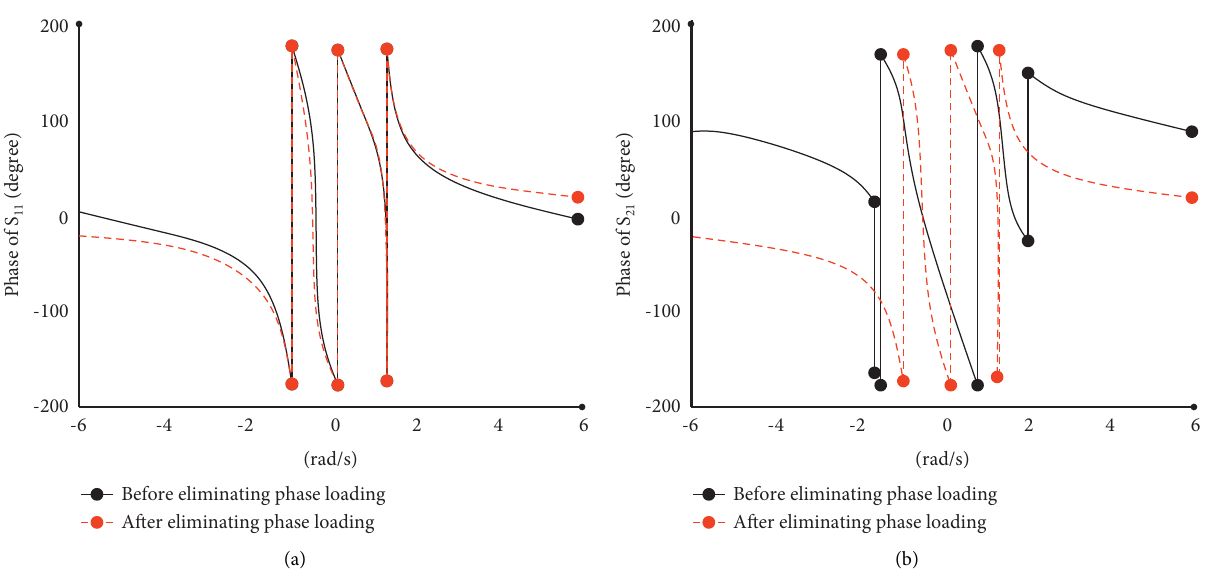
Figure 3: Comparison diagram after removing the loading phase. (a) Comparison before and after removing the loading phase S Comparison before and after removing the loading phase S